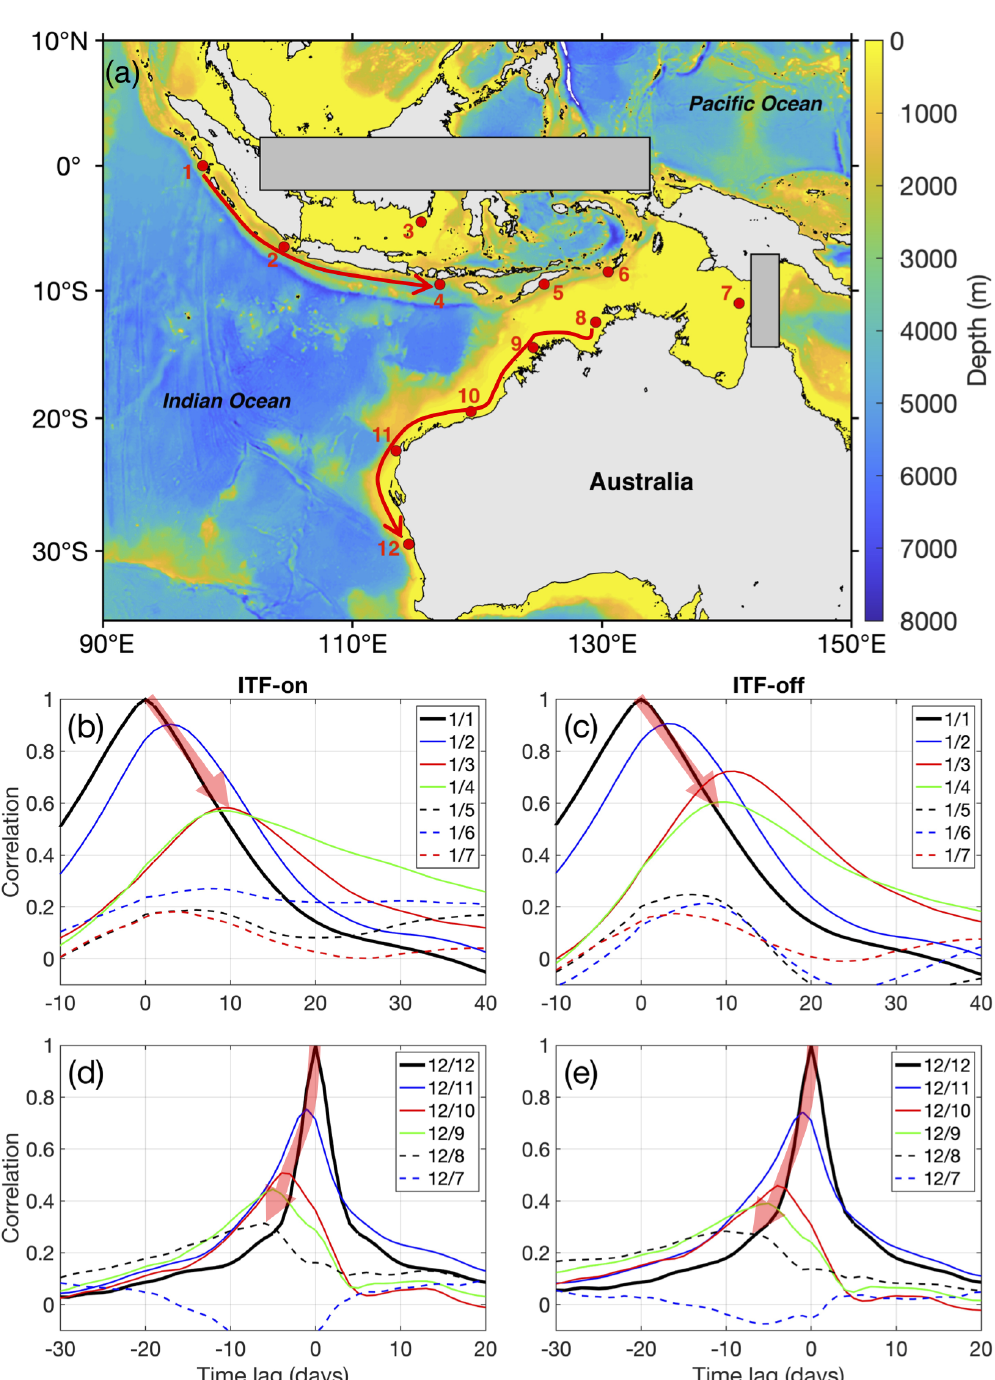
Figure 3. (a) Bottom topography in the ESIO and the locations (1 to 12) used for cross-correlation analysis. Cross-correlation functions between the daily SLA in (b, d) the ITF-on and (c, e) the ITF-off simulations. The locations 1 and 12 are used as reference points to detect waves propagating along the Maritime Continent from 1 to 7 (b, c) and along the west Australian coast from 7 to 12 (d, e) . The red arrows connect the peaks of cross-correlation functions associated with coastal trapped